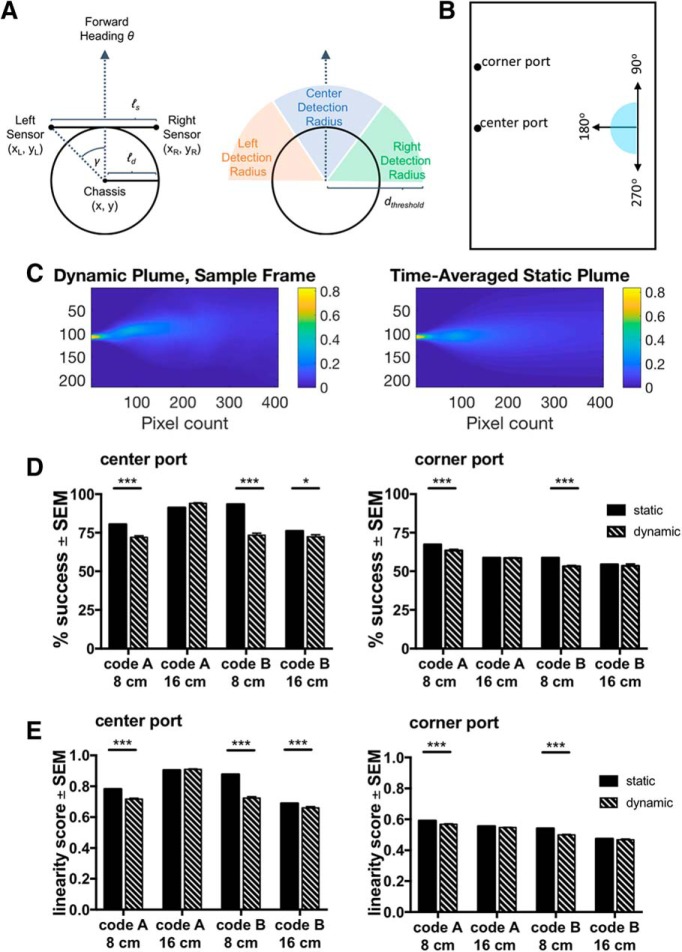
In silico models show decreased performance with increased odor environment complexity. A, Model virtual chassis moves through space with a heading, θ. Two sensors are separated at a distance ℓsand an angle γ (left). If the center of the model reaches dthreshold = 10 cm of the wall, the model will take corrective measures (right; described in Materials and Methods). B, Model is tested at angles ranging from 90° to 270° with a start position in the center of the arena. Model is tested on two plumes, one originating from a center port and one from a corner port. C, Sample frame depicting instantaneous concentration of the dynamic plume normalized to odor source (left), and an image of the stationary concentration gradient in static plume normalized to odor source (right). D, Performance (average % success of all start angles ± SEM) across code and sensor distance for center target port (left) and corner target port (right); n = 20 simulations. E, Linearity score (calculated as the ratio of the Euclidean distance between start point and end point of trajectory and the actual pathlength) across code and sensor distance for center target port (left) and corner target port (right). Plot shows mean linearity score ± SEM, n = 20 simulations. See also Extended Data Figures 3-1, 3-2, 3-3, 3-4, 3-5, and 3-6. *p < 0.05, **p < 0.01, ***p < 0.001.